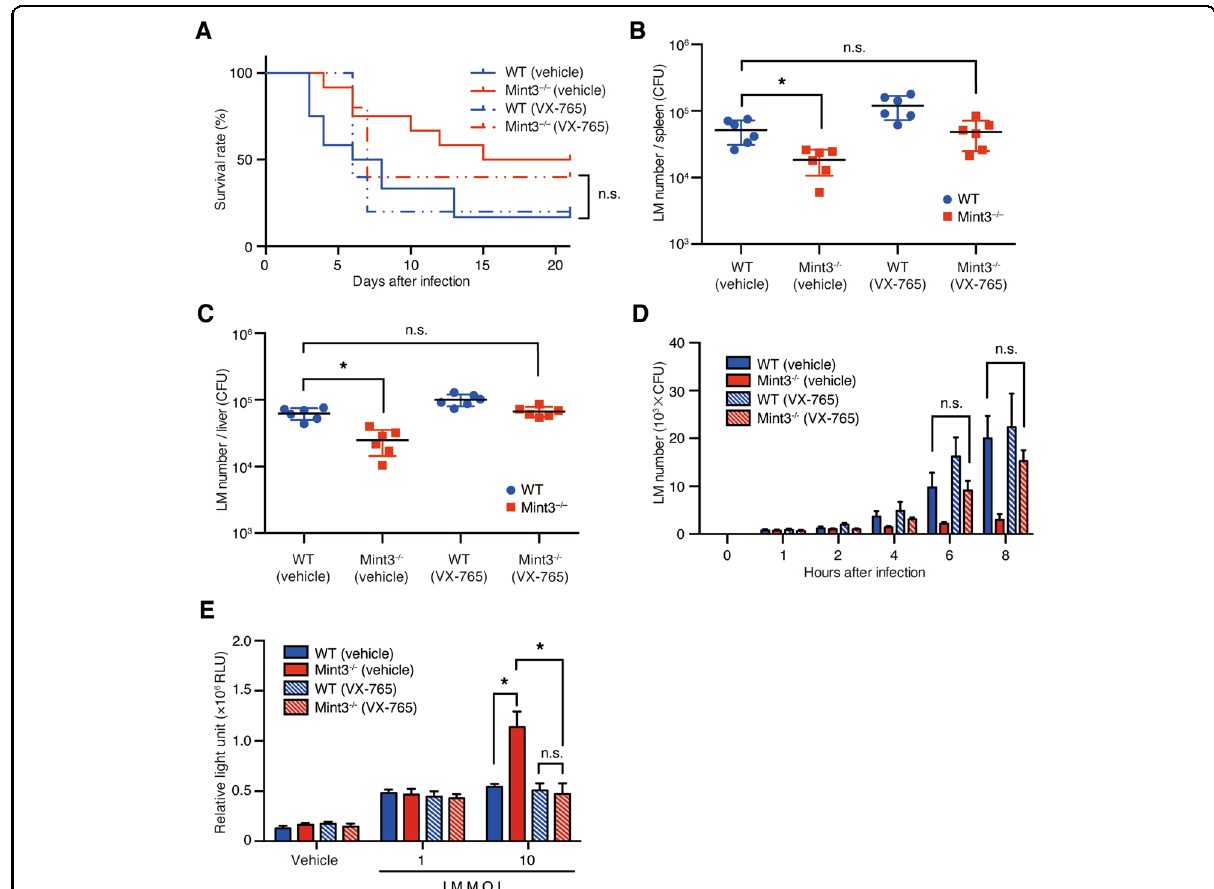
Fig. 7 Resistance to LM infection caused by de fi ciency of Mint3 is mediated by a caspase-1-dependent mechanism. A – C In fl uence of the caspase-1 inhibitor VX-765 on LM infection in vivo. A WT and Mint3 – / – mice ( n = 10 per group) were infected via intraperitoneal injection of 2 × 10 5 CFUs of LM, followed by the assessment of survival rates. Each mouse received intraperitoneal pre-administration of either control vehicle or VX-765 (50 mg/kg) 1 h before LM infection. Data are representative of two independent experiments. * P < 0.05 by the log-rank test. B The bacterial burdens in the spleen and C liver were counted 1, 3, and 7 days after LM infection. Data are presented as the means ± SEMs and are representative of two independent experiments. * P < 0.05 by the Mann – Whitney U test. D In fl uence of VX-765 on LM infection in vitro. BMMFs from WT or Mint3 – / – mice were infected in vitro with 10 5 CFUs of LM (MOI = 1), following pretreatment with either control vehicle or VX-765 (10 μ M) 1 h before LM infection. The bacterial burdens were determined 1, 2, 4, 6, and 8 h after infection. Data are presented as the means ± SDs of triplicates. Data are representative of two independent experiments. * P < 0.05 by the Student ’ s t -test. E The cell deaths in LM-infected WT and Mint3 – / – BMMFs treated with VX-765 (10 μ M) were assessed by quantifying the LDH contents of the supernatants 12 h after LM infection. Data are presented as the mean ± SD of triplicates and are representative of two independent experiments. * P < 0.05 by Student ’ s t